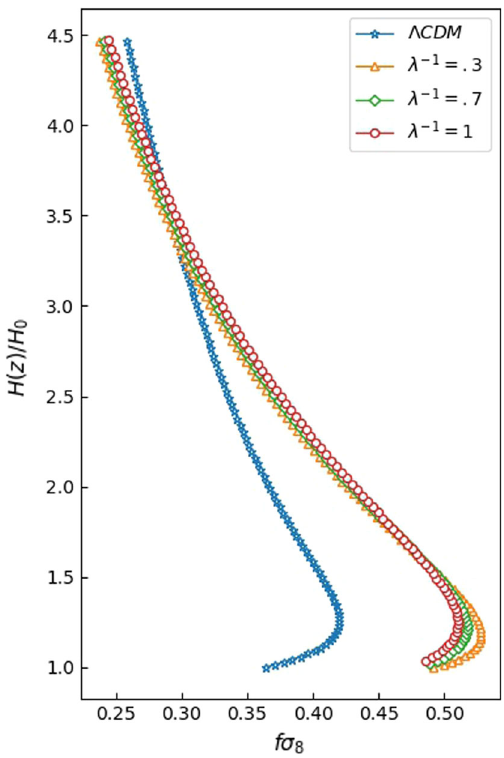
Fig. 11 [ f σ 8 ] ( z ) × H ( z )/ H 0 curves for the models Λ CDM and Starobinsky f ( R ) with different values for the parameter λ and n = 1